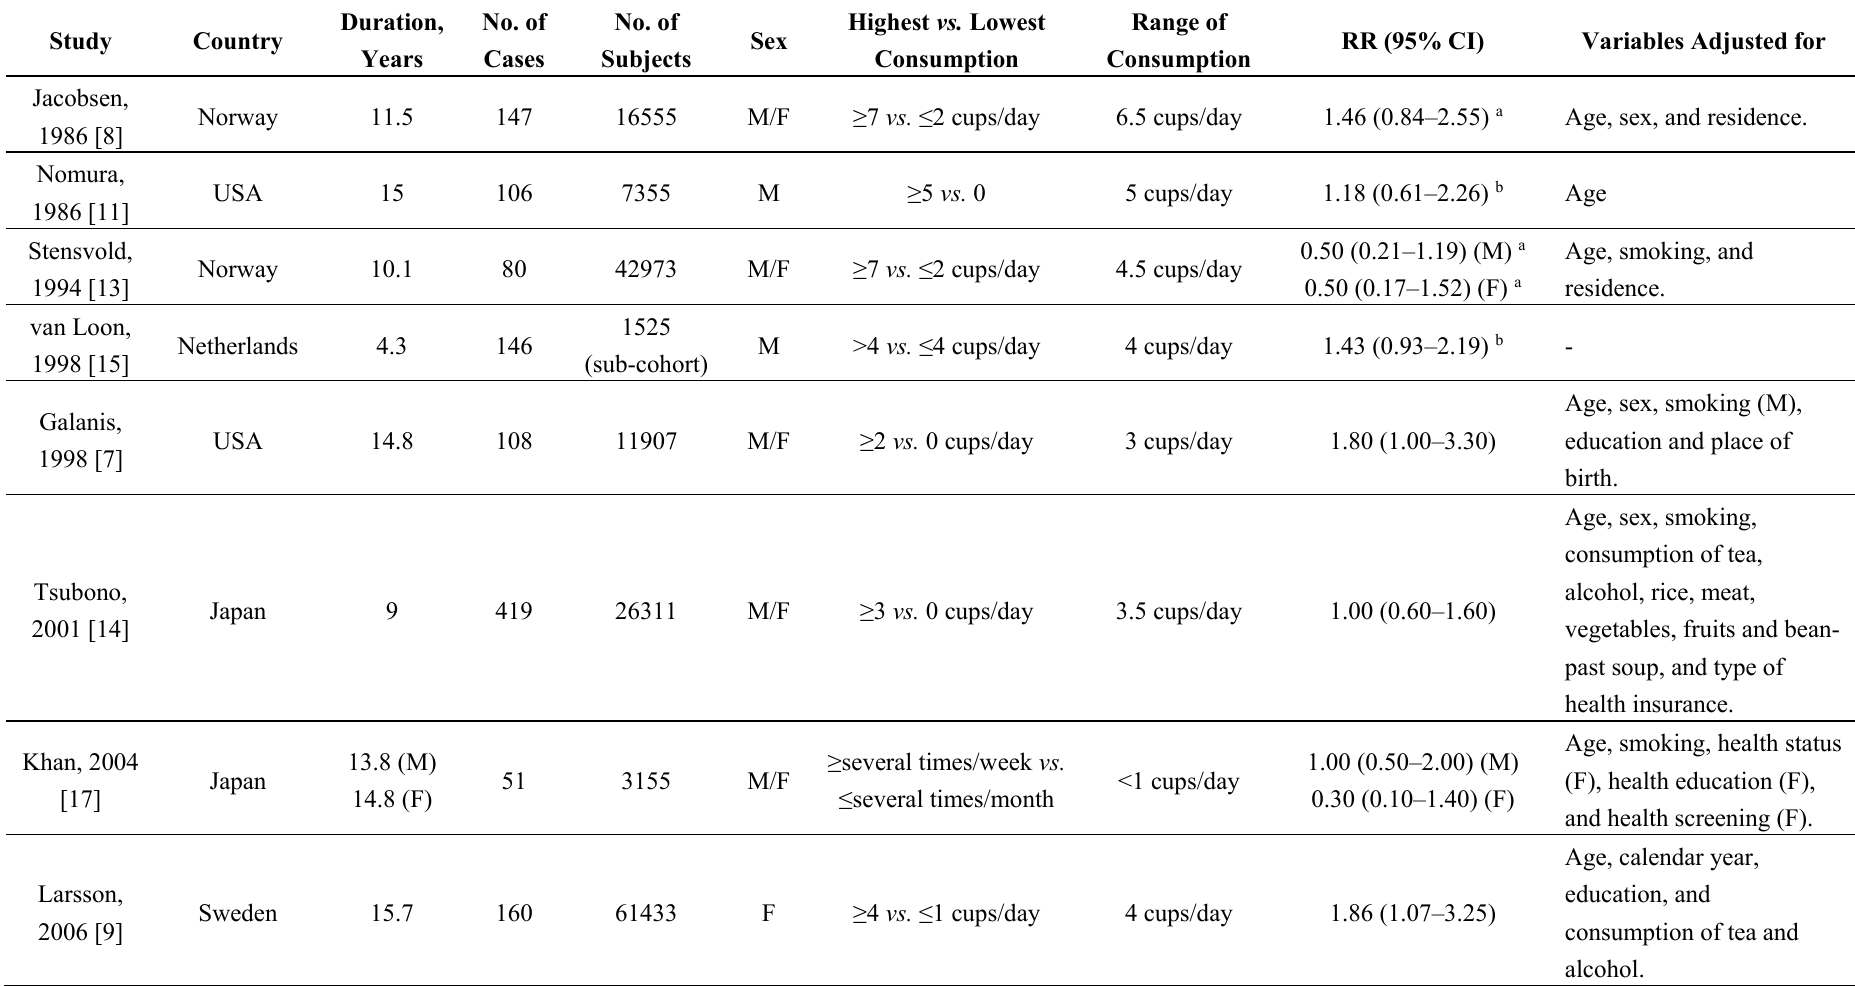
Table 1. Characteristics of included prospective studies examining the association between coffee consumption and risk of gastric cancer.